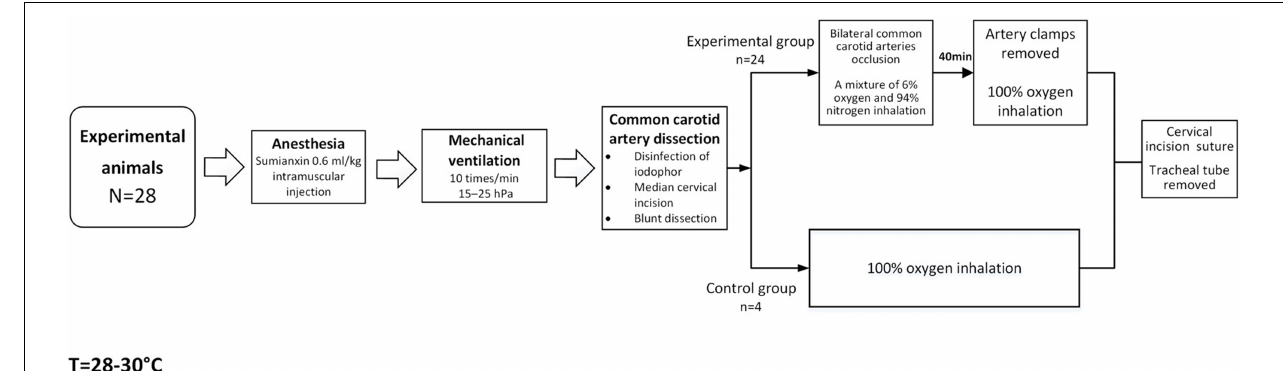
FIGURE 1 | Flow chart of animal